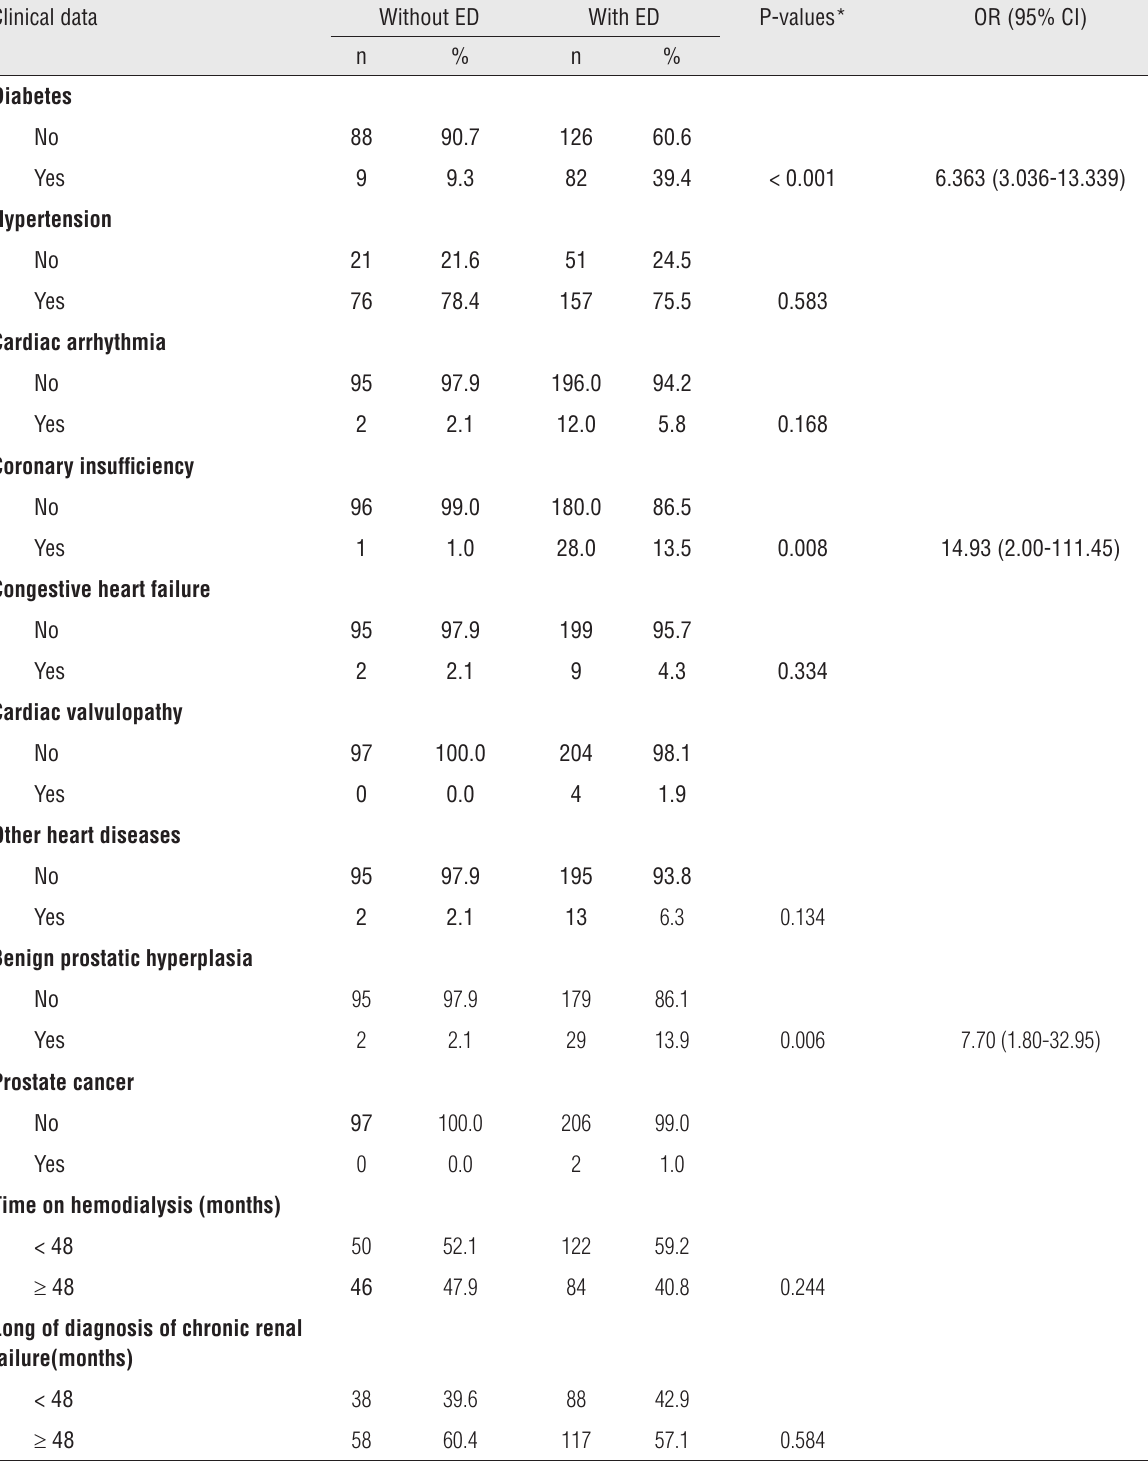
Table 4 - Association of clinical data with Erectile Dysfunction in hemodialysis patients. Clinical data Without ED With ED P-values* OR (95% CI)